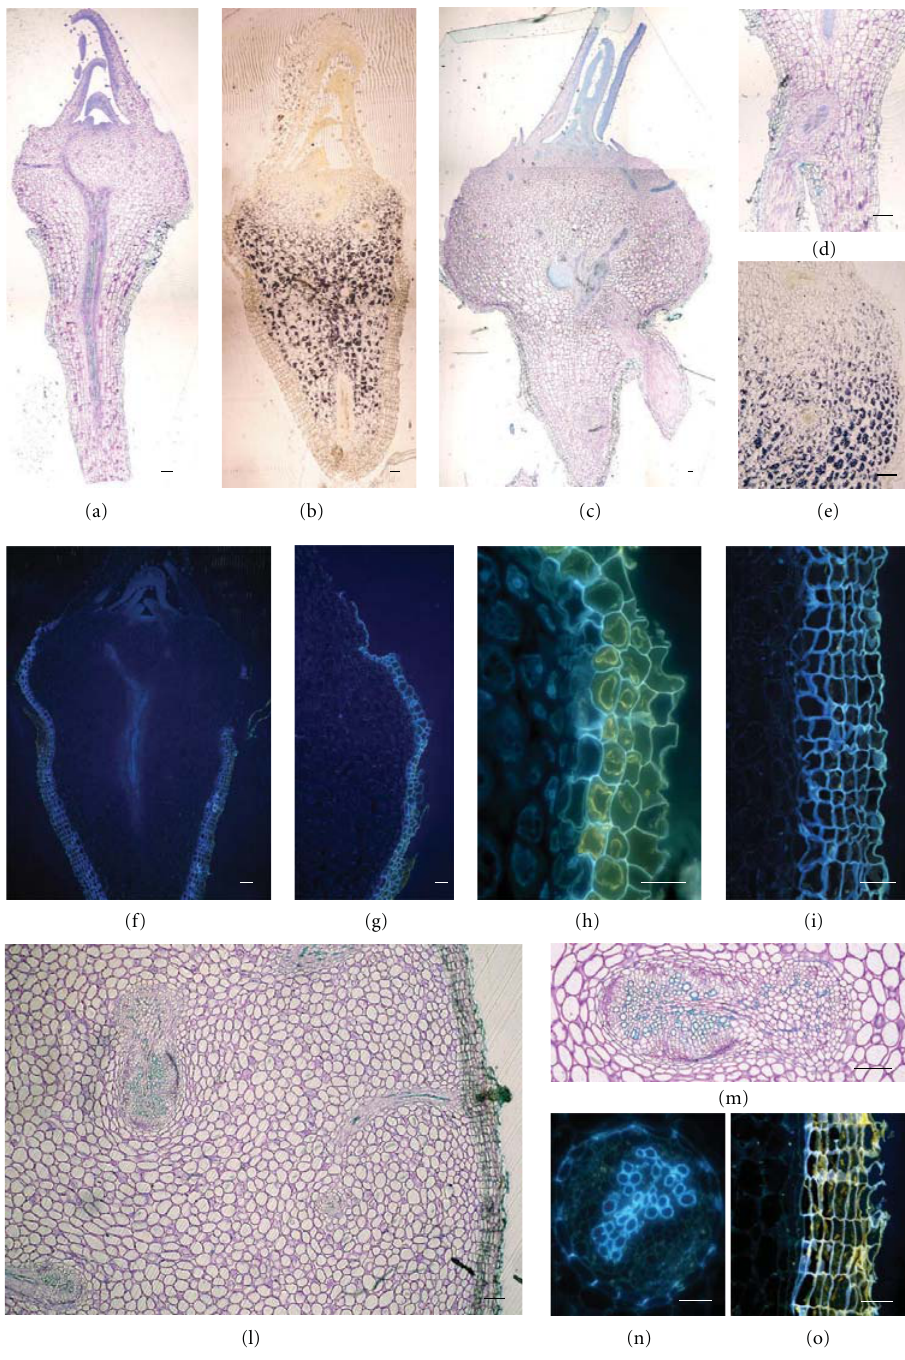
Figure 6: Photomicrographs of longitudinal sections of very young P. palinuri plants developed in controlled conditions (a)–(i) and of cross-sections of the rhizome of young and adult plants collected in the fields (l)–(o) viewed under light and epifluorescence microscopy. Subepidermal suberized layers (blue fluorescence) increasing in number if moving towards the below-ground region of the very young plants (f) and (g); endodermal Casparian bands in the stele of rhizome (n) and suberized subepidermal layers at the periphery of the rhizome (o). (h) hypocotyl; (i) root; (m) periphloematic vascular bundle. Bars are 10 μ m in (a)–(f), (l), (m), and 50 μ m in (h), (i), (n), and